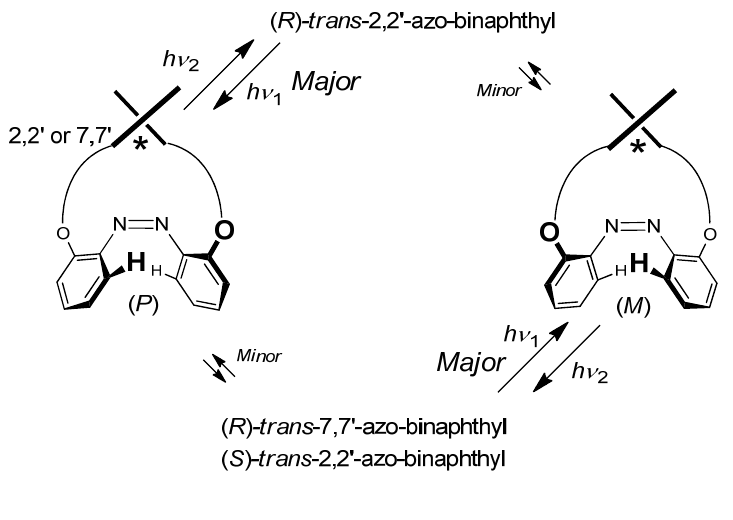
Figure 15. Twisting pattern of cis -azobenzenes induced by axial chirality of